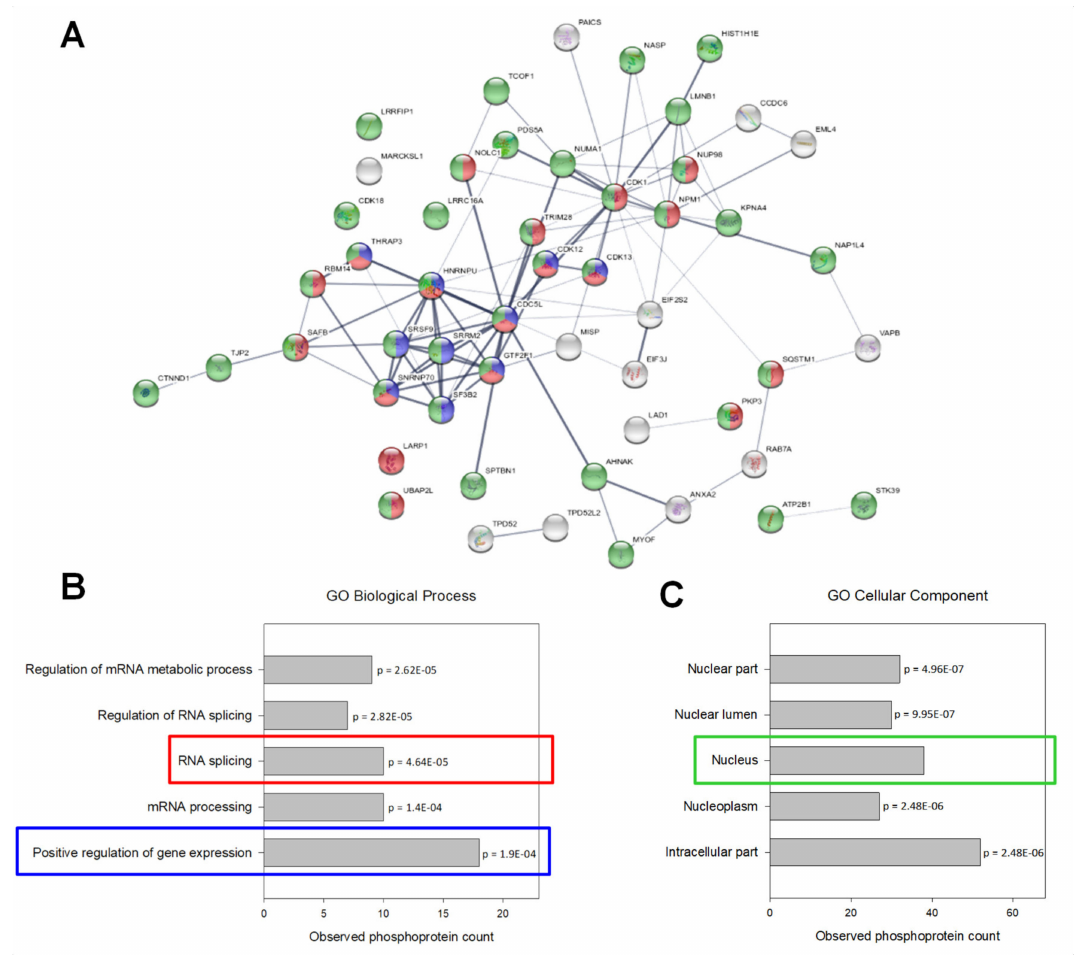
Figure 6. Phosphoproteomic data analysis. ( A ) Interaction network of regulated phosphoproteins (generated by STRING v11.0). The connecting lines between protein nodes represent protein-protein interactions and the thickness of the edge indicates interaction score (minimum interaction score = 0.4). Coloring of proteins is based on further enrichment analysis. Proteins marked in red and blue are involved in RNA splicing and positive regulation of gene expression, respectively. Nuclear phosphoproteins are marked in green. ( B , C ) Enrichment analysis of phosphoproteins with regulated phosphorylation (performed in STRING v11.0). Graphs are showing the most enriched Gene Ontology (GO) Biological Processes ( B ) and Cellular Compartment ( C ) among the regulated phosphoproteins with observed protein count in each category and calculated p values corrected for multiple testing (Benjamini and